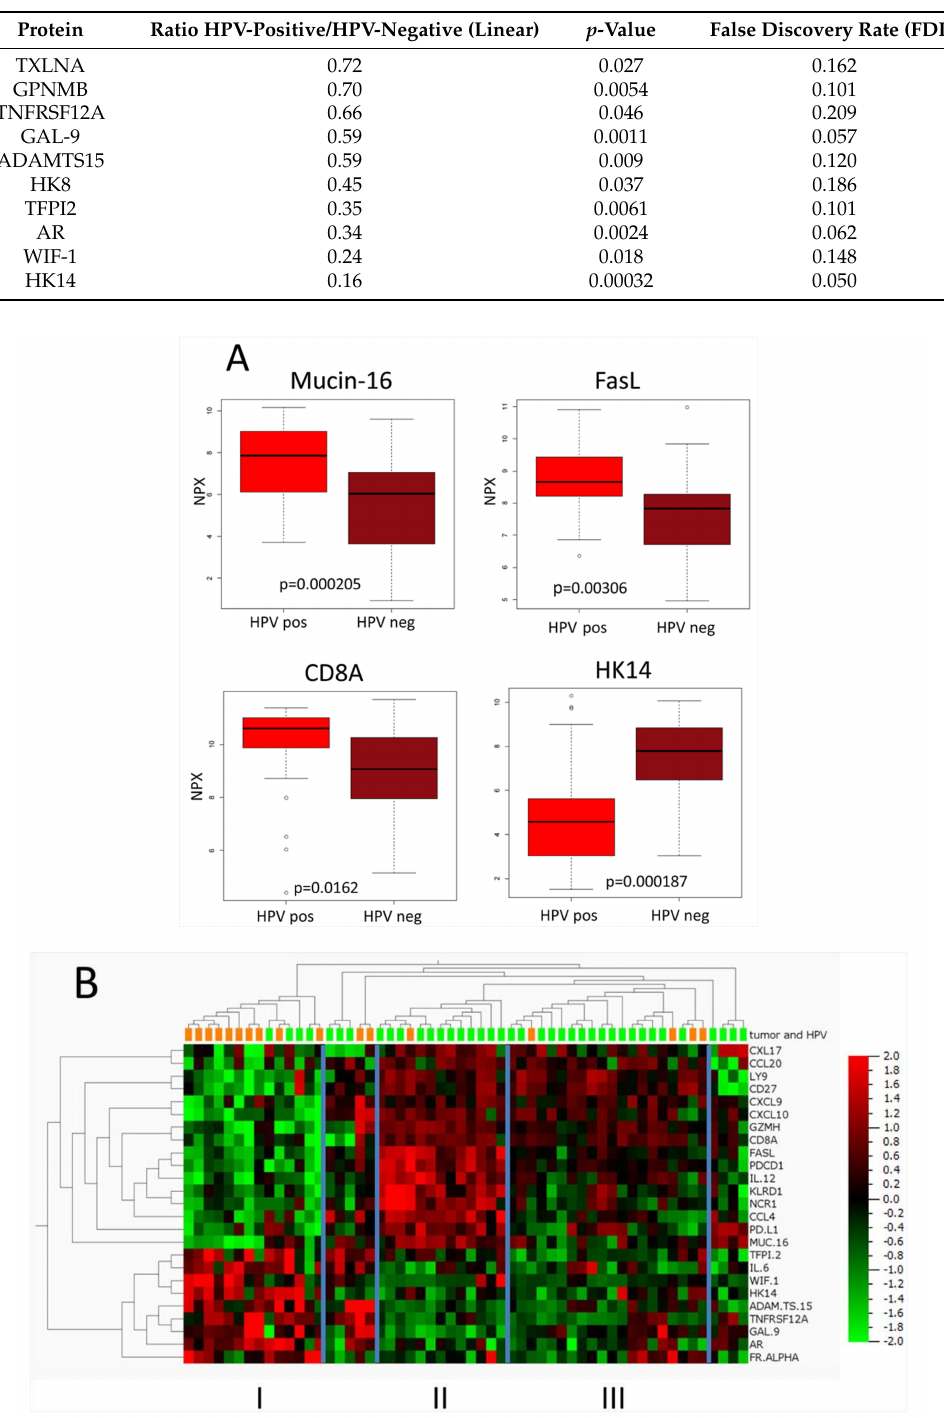
Figure 1. Protein expression in human papillomavirus (HPV) positive and negative TSCC/BOTSCC. ( A ) Boxplots presenting the expression of Mucin-16 (MUC16), Fas ligand (FasL), CD8A, and Human Kallikrein 14 (HK14) in HPV positive and negative TSCC/BOTSCC. NPX-values in 2-log scale. ( B ) Heatmap presenting the expression of 22 proteins with significant differences and >1.5 fold difference between HPV positive and negative TSCC/BOTSCC. Green, HPV positive and orange, HPV negative tumors. Three tentative clusters of samples are marked as I, II, and